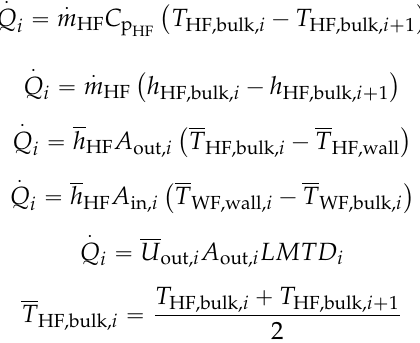
Figure 4. Control volume depicting the inlet/outlet temperatures of the two fluids.